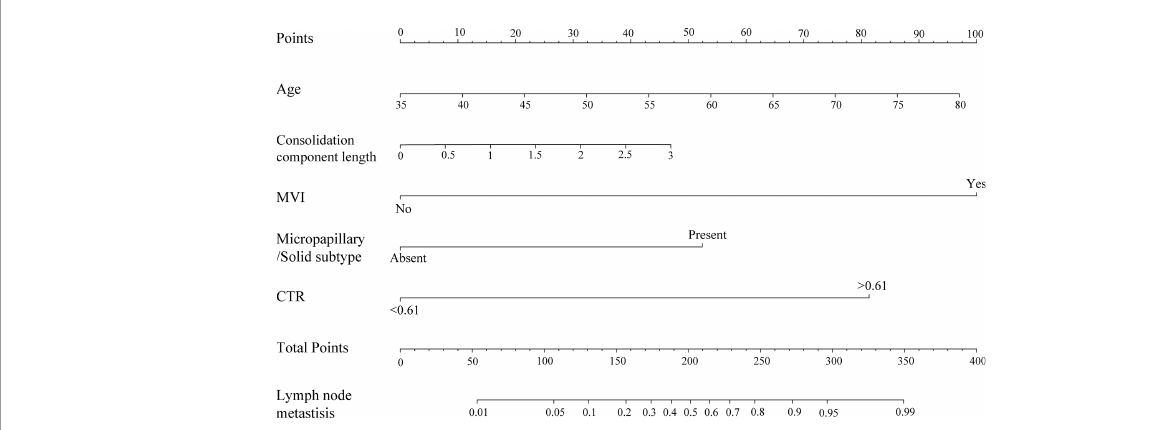
FIGURE 3 | Nomogram for the prediction of lymph node metastasis of patients with lung adenocarcinoma manifested as PSNs. To use the nomogram, fi nd the position of each variable on the corresponding axis, draw a line to the points axis for the number of points, add the points from all of the variables, and draw a line from the total points axis to determine the probabilities of lymph node metastasis at the lower line of the nomogram.